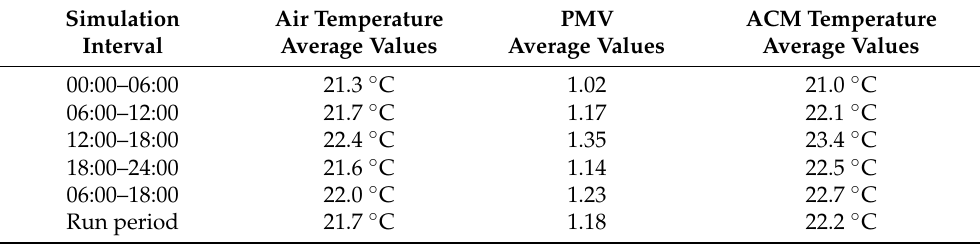
Table 13. Indoor environmental analysis data for the Materdei building as a result of retrofitting actions.